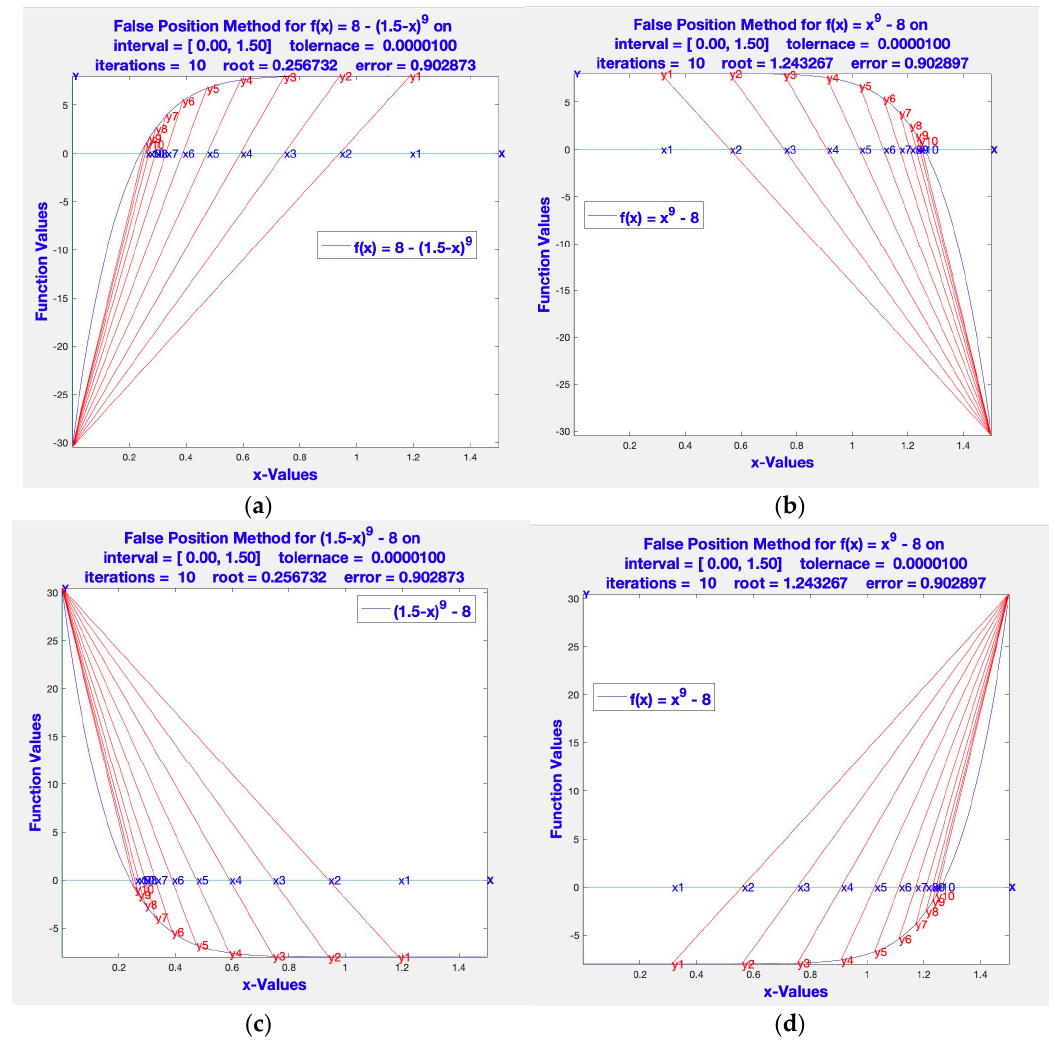
Figure 1. ( a ) Convex function concave up, left endpoint fixed. ( b ) Convex function concave up, right endpoint fixed. ( c ) Convex function concave down, left endpoint fixed. ( d ) Convex function concave down, right endpoint